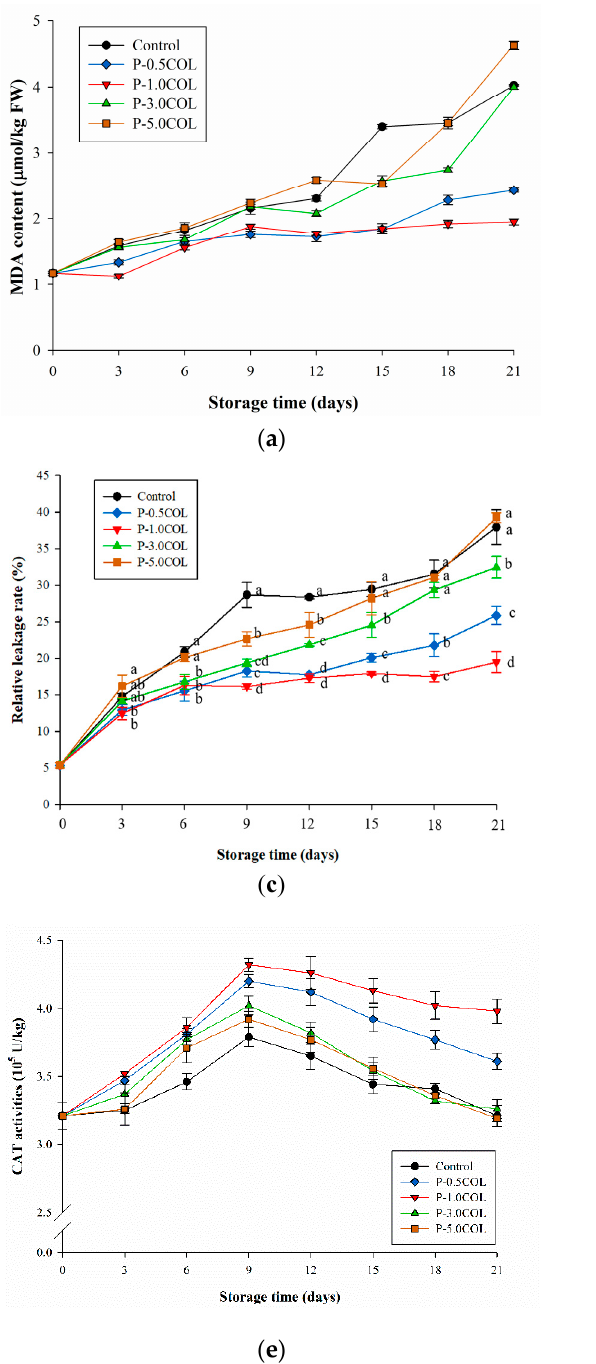
Figure 5. Effects of different packaging films on respiratory injury of A. bisporus stored at 4 °C for 21 days. ( a ) MDA in different packaging in different COL packaging films. ( b ) MDA in different packaging in different CMC packaging films. ( c ) Relative leakage in different COL packaging films. ( d ) Relative leakage in different CMC packaging films. ( e ) CAT activity changed in different COL packaging films. ( f ) CAT activity changed in different CMC packaging films. a–e Means followed by different superscripts indicate the statistically significant different values among treatments at the same storage time ( p < 0.05).